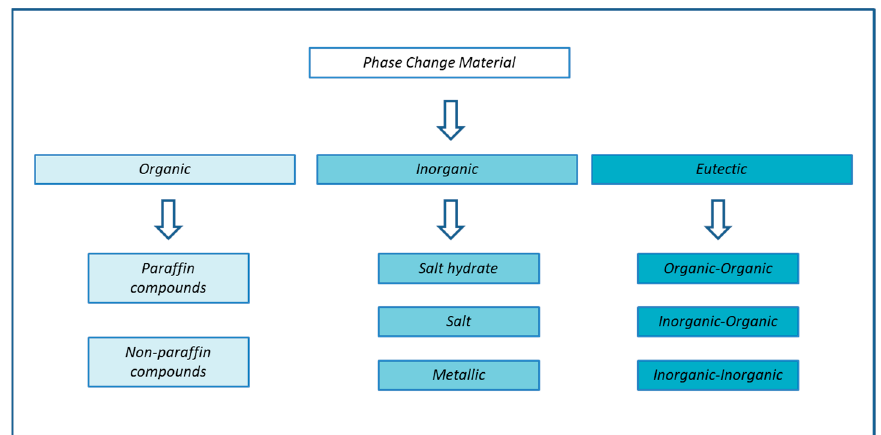
Figure 1. General classification of PCM.